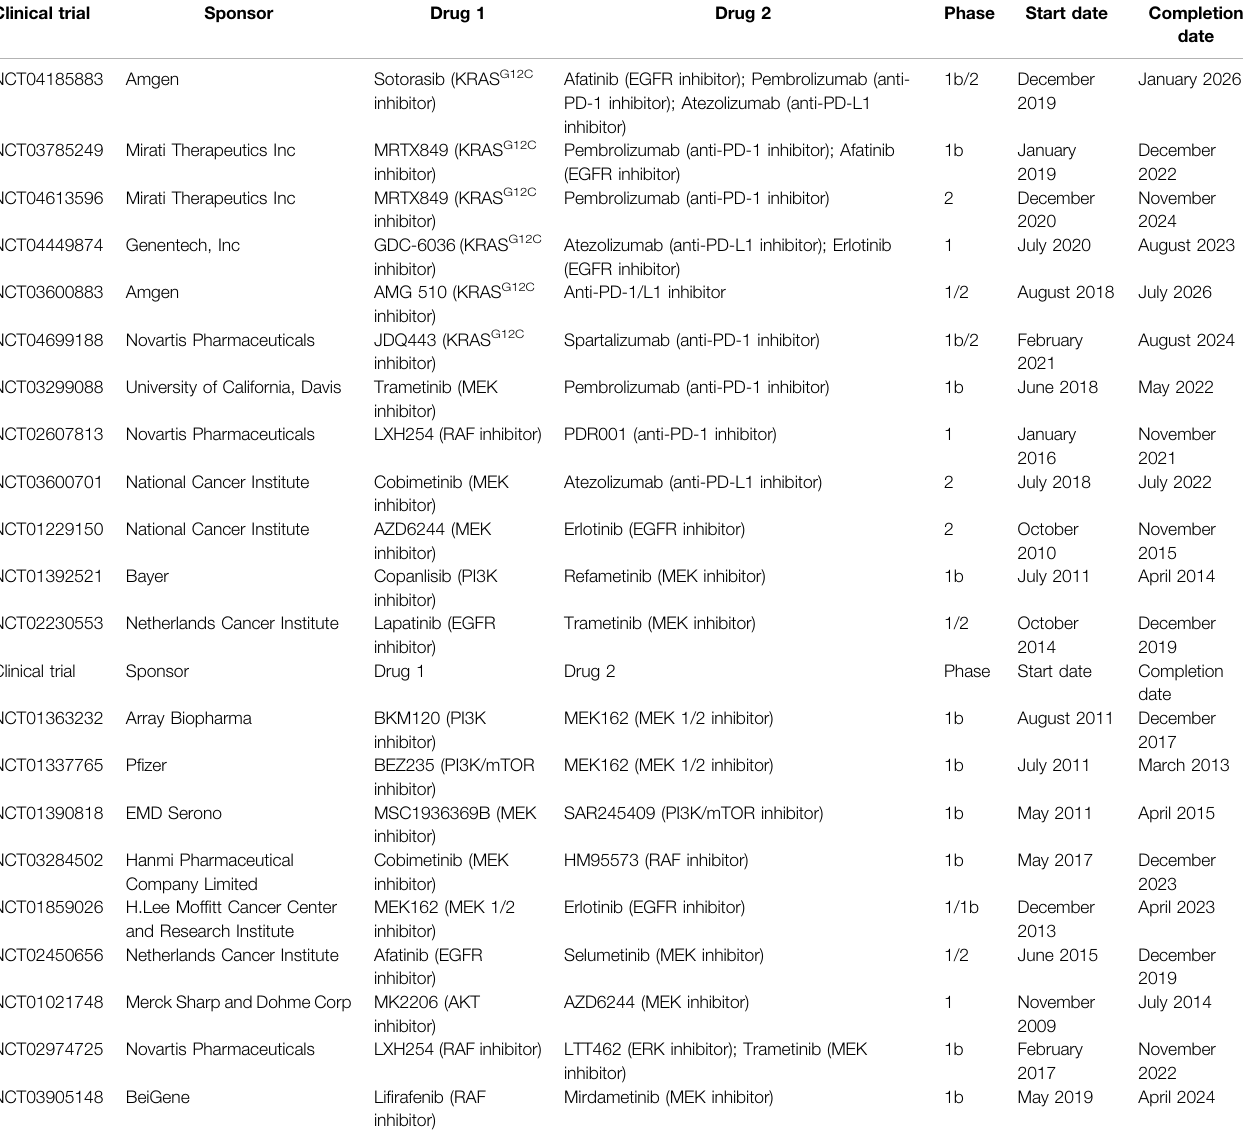
TABLE 4 | Combinational strategies in clinical development for treating KRAS-mutant NSCLC. Clinical